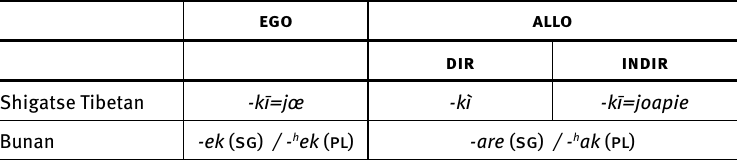
Table 4. Egophoricity and evidentiality in the two languages (present / imperfective)